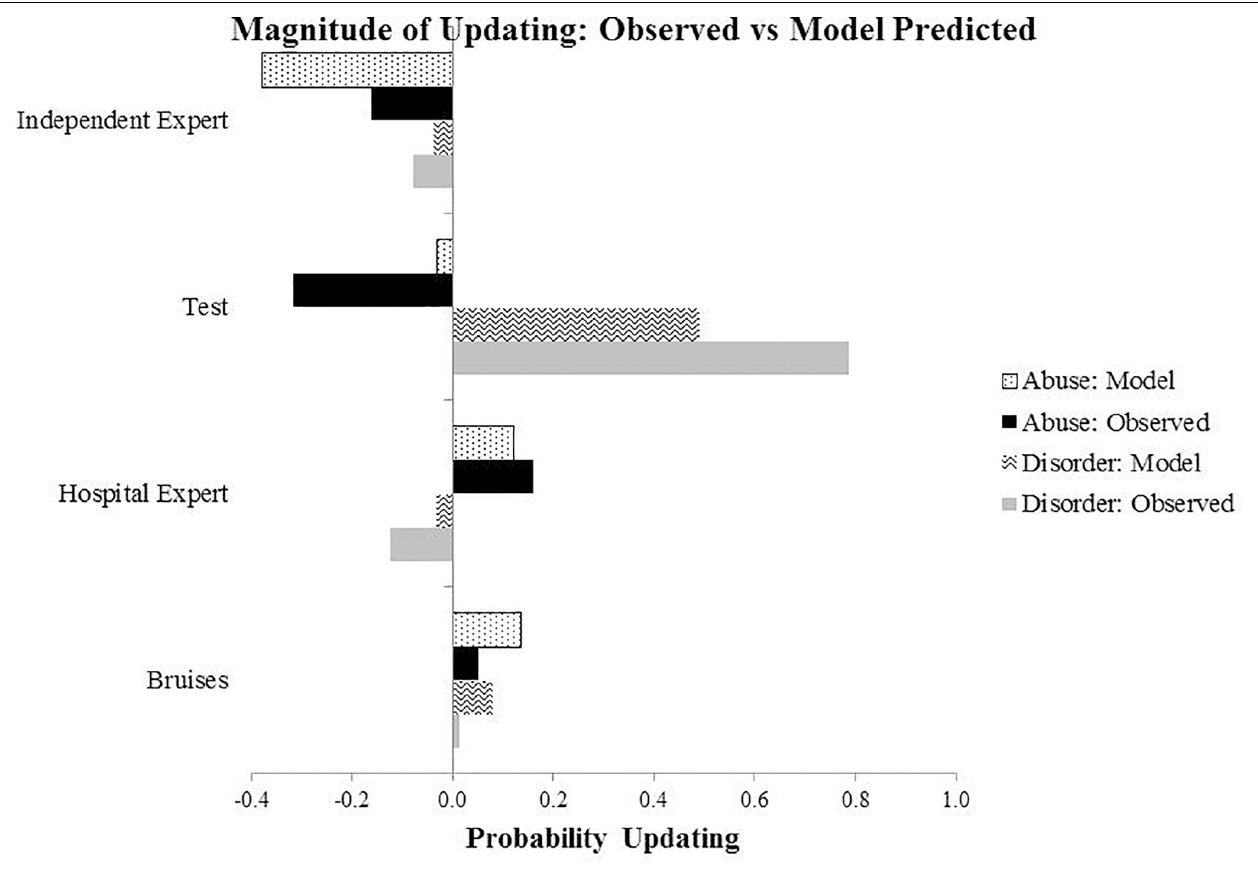
FIGURE 3 | Results from Experiment 1: The graph shows extent of updating at four stages of evidence presentation, calculated as a difference between the probability estimates at the present and previous evidence stage. For example, for the Bruises stage, this is calculated by subtracting the probability value at the previous stage (prior elicitation) from the present stage (evidence of